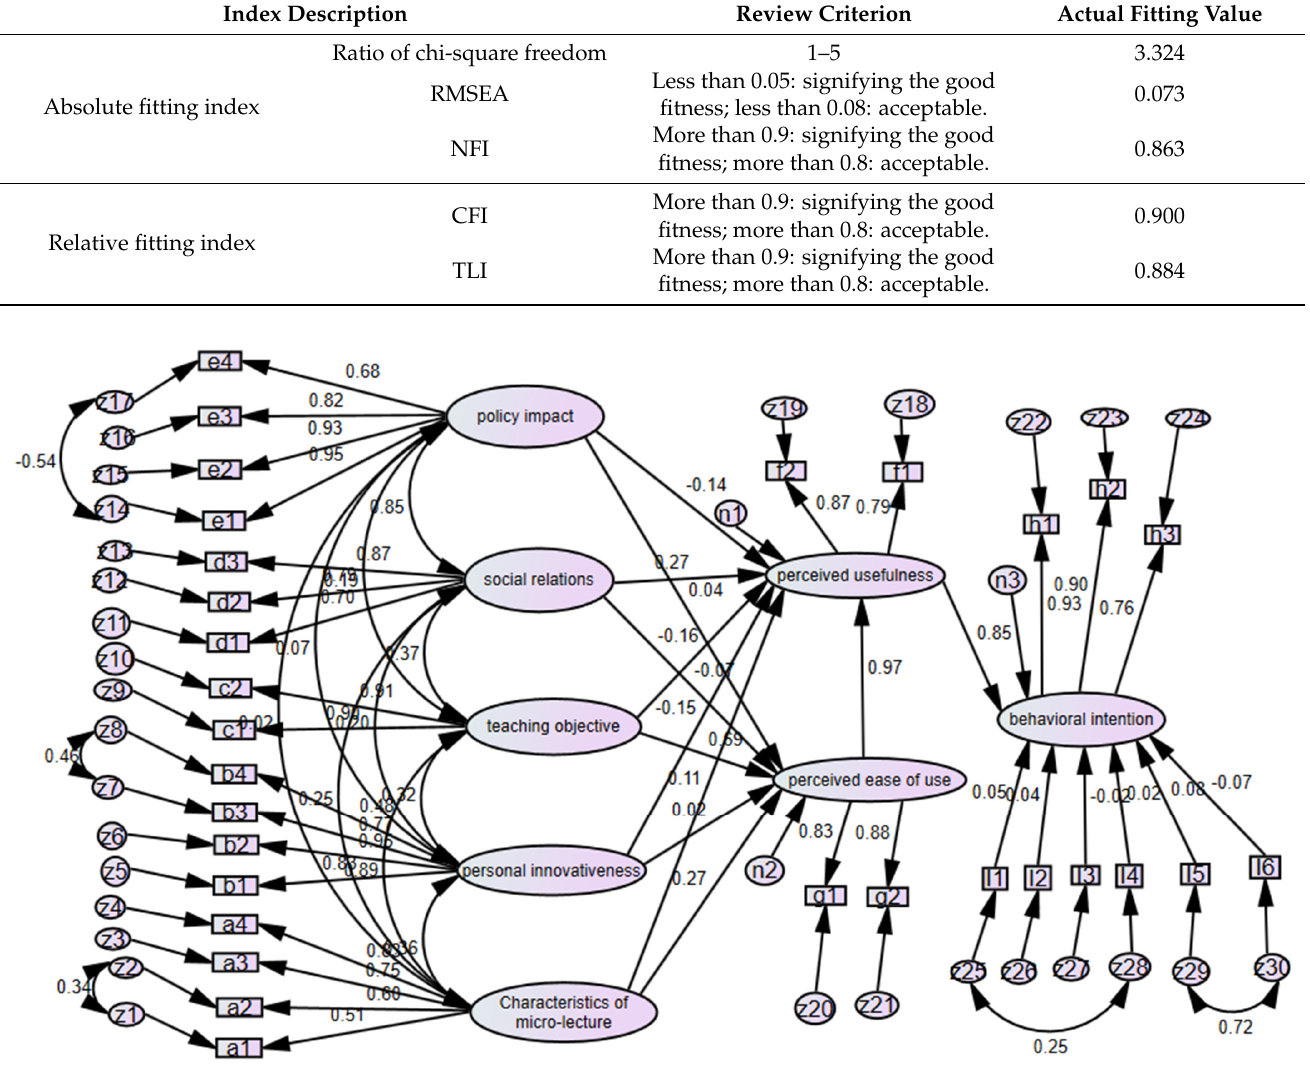
Figure 5. Validation of research hypotheses. (*: Significant at 0.1 level; **: Significant at 0.05 level; ***: Significant at 0.01 level. )